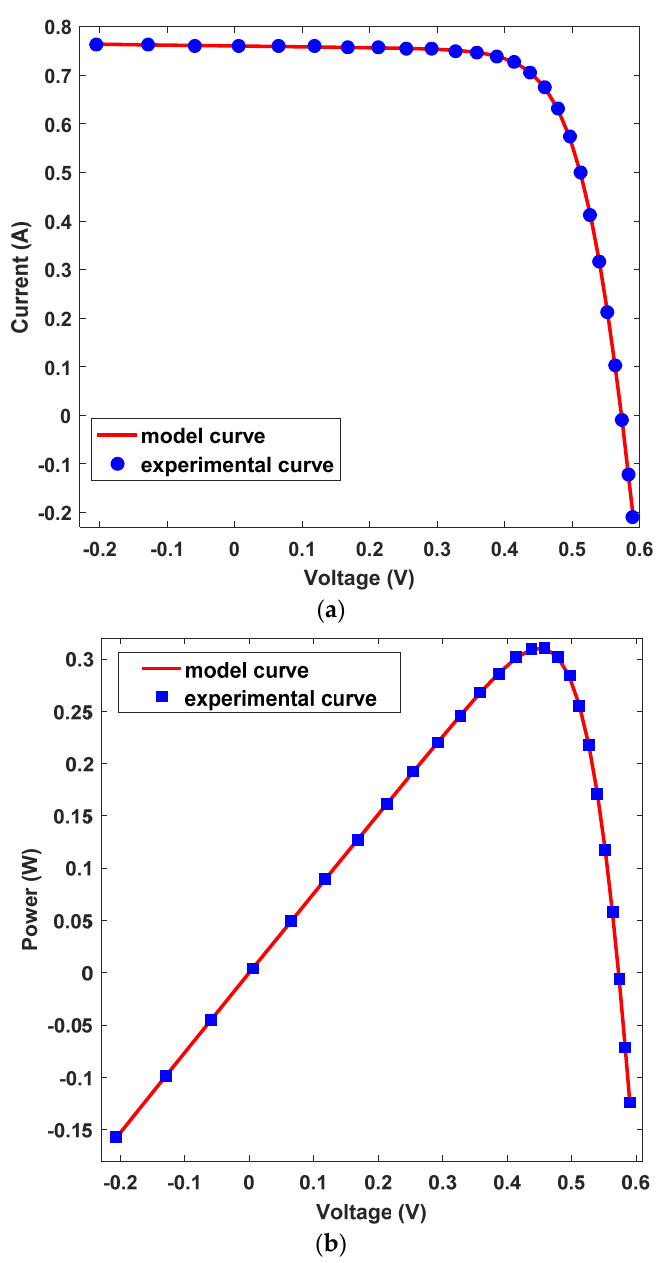
Figure 19. Comparisons between measured data and data achieved using the MECPO method for TDM ( a ) I–V characteristics and ( b ) P–V characteristics.